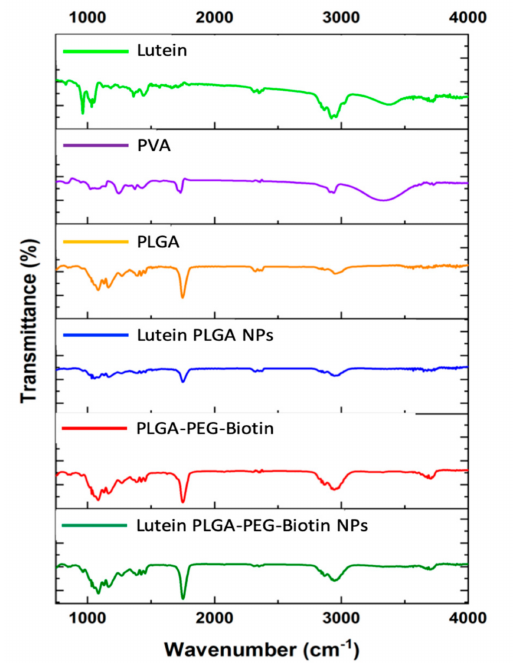
Figure4. Fourier-transforminfraredspectroscopy(FTIR)spectraoffreeze-driedlutein-loadedpolymeric nanoparticles, PLGA, PLGA–PEG–biotin, PVA, and lutein.